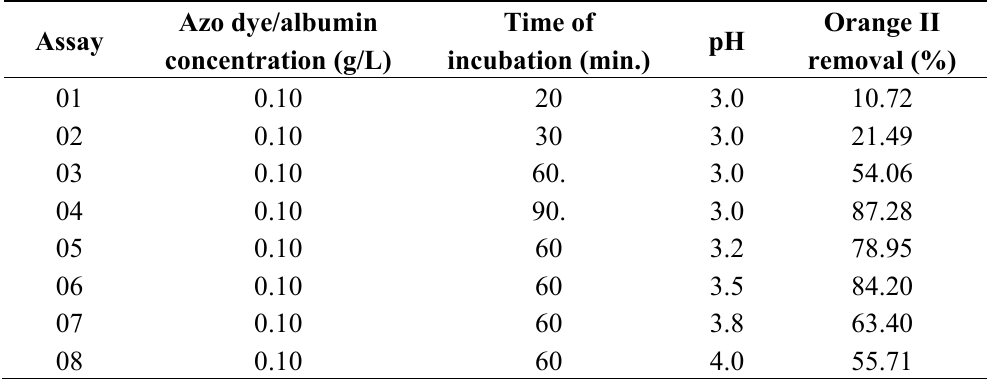
Orange II Time of pH removal (%) incubation (min.)